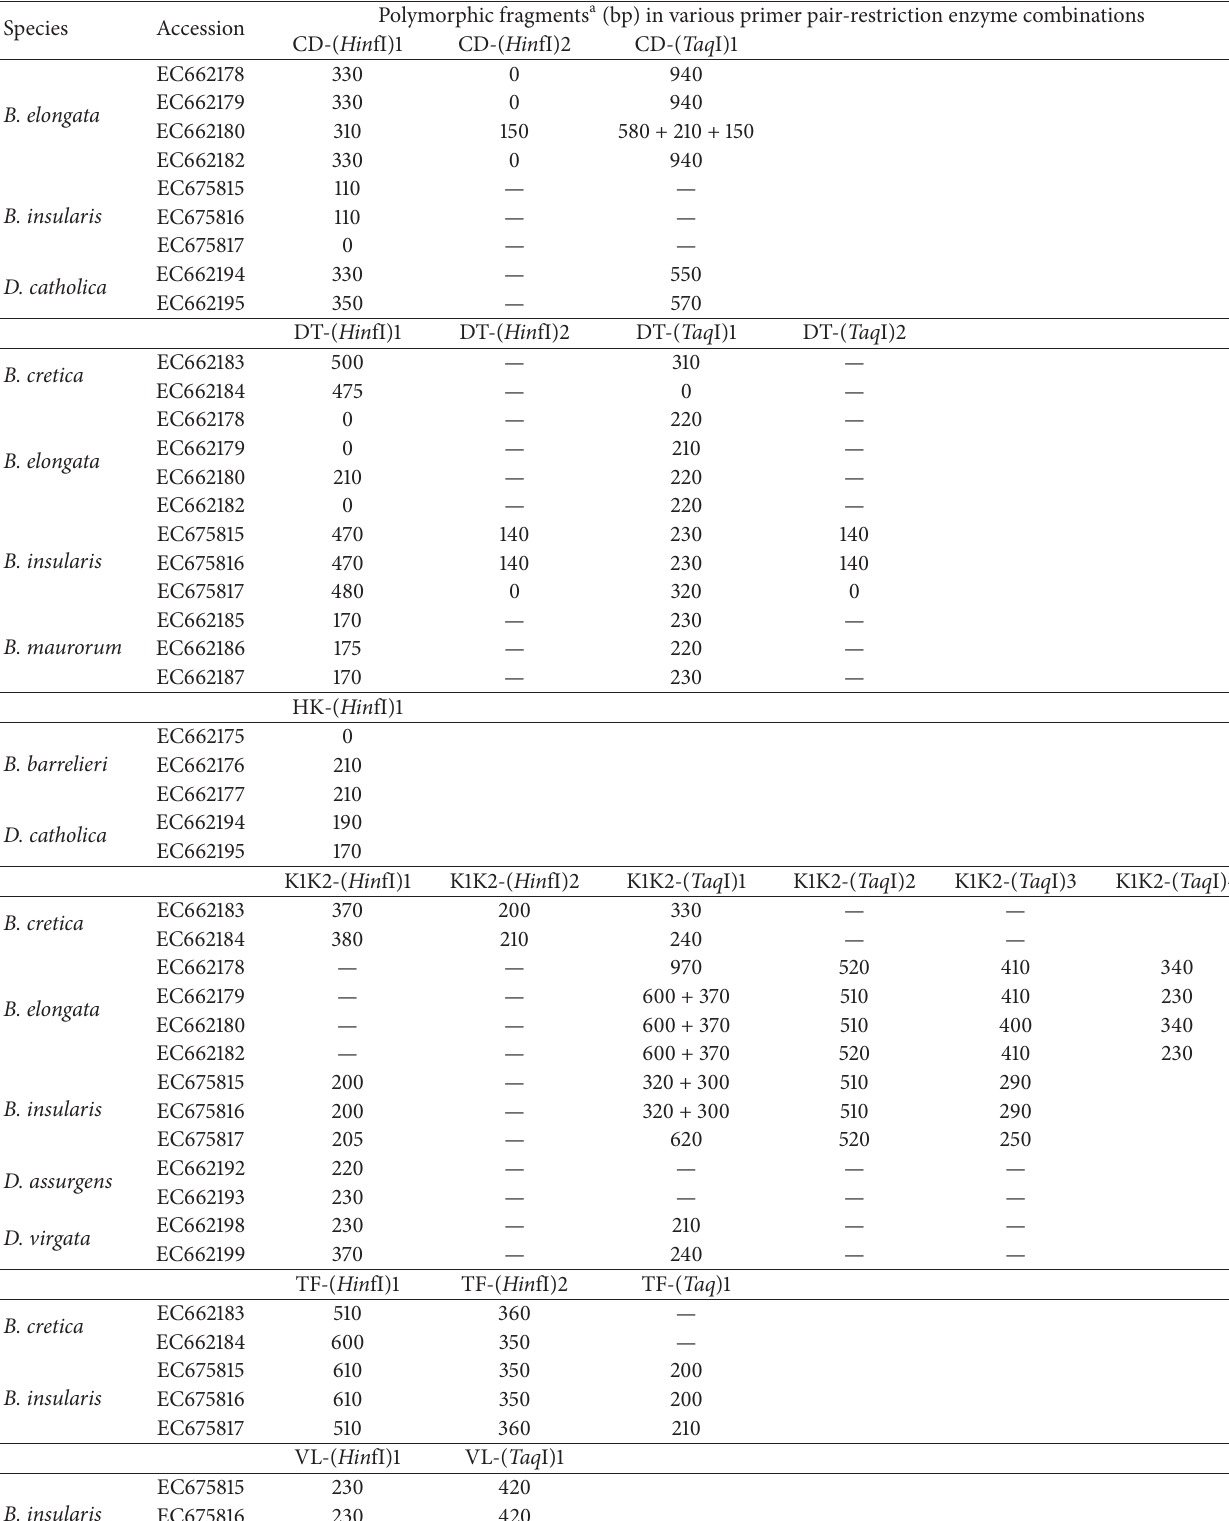
Table 3: Polymorphic fragments obtained with various primer pair-restriction enzyme combinations to reveal intraspecific variations in wild